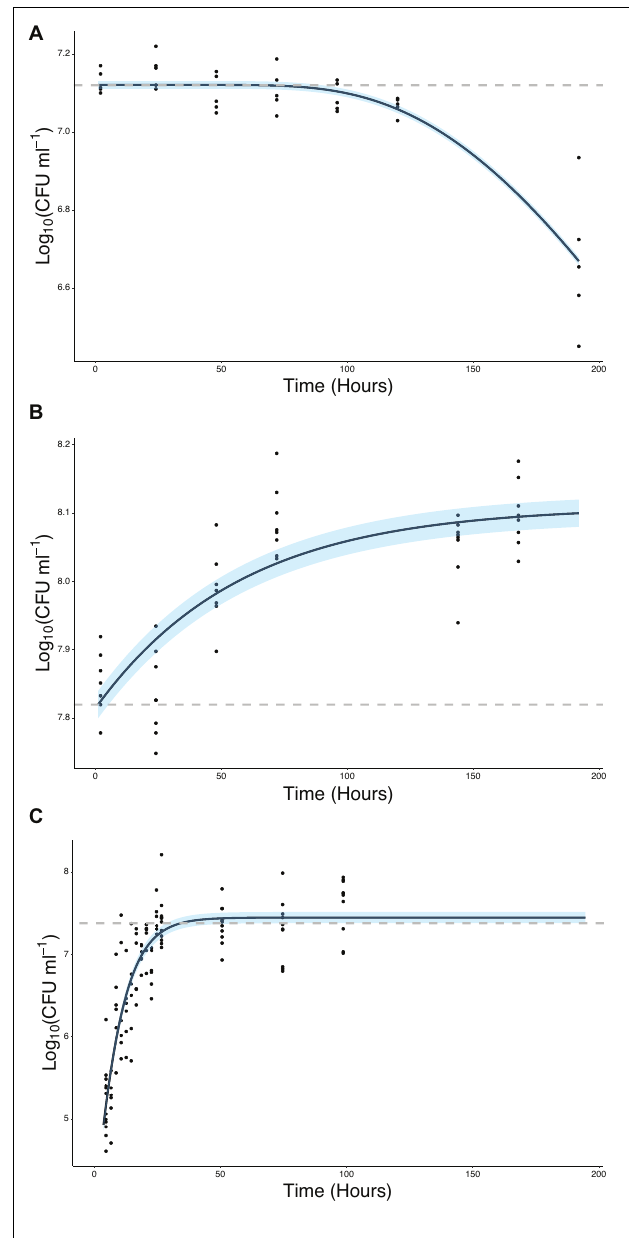
FIGURE 4 | Bacteria proliferate in the presence of the root or root exudate, but not in the absence of any root input. (A) The change in Log 10 (CFU) of P. fluorescens SBW25 E1433 in a microcosm system over time in the absence of a plant root or root exudate. Here bacterial numbers in suspension were quantified in microcosm systems containing 1/2 MS plant growth media and no plant ( Figure 2 iii). (B) The change in Log 10 (CFU) of P. fluorescens SBW25 E1433 in a microcosm system over time in the absence of a plant root but presence of root exudate. Here bacterial numbers in suspension were quantified in microcosm systems filled with exudate from lettuce roots ( Figure 2 iii). (C) The change in Log 10 (CFU) of P. fluorescens SBW25 E1433 in a microcosm system over time in the presence of a plant root. Here bacterial numbers in suspension were quantified in microcosm systems containing a plant ( Figure 2 iv). Black lines represent the relevant fitted model ( Table 1 ). Gray dashed lines represent the average initial value for Log 10 (CFU) in the original inoculant across different replicates of the same treatment. Shaded regions represent bootstrap